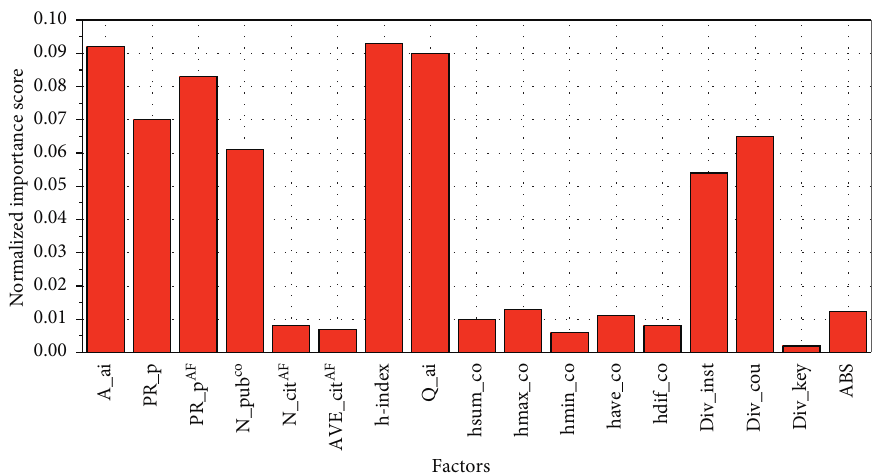
Figure 4: Complex factors’ importance